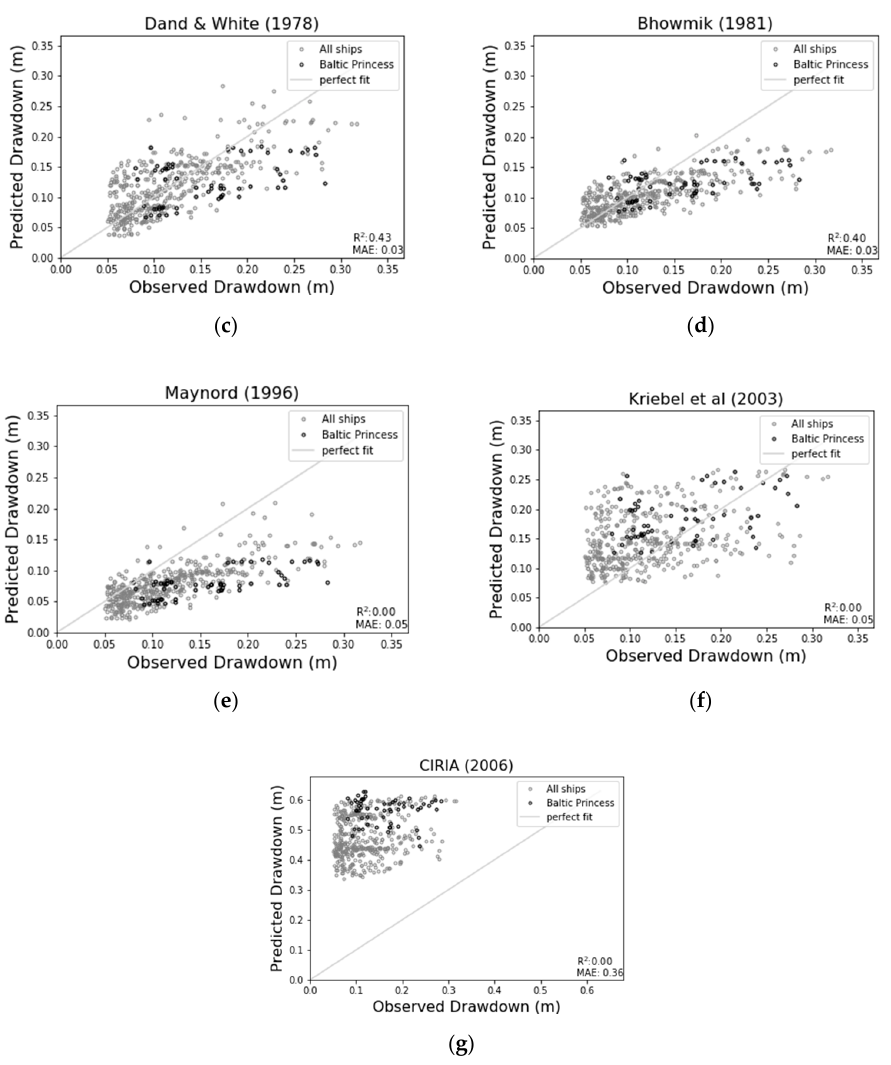
Figure 8. Calculated drawdown height with empirical equations versus measured drawdown height at Nykvarnsholme and Björnhuvud for the existing drawdown equations of Shijfs [11] ( a ); Hochstein [24] ( b ); Dand & White [25] ( c ); Bhowmik [17] ( d ); Maynord [10] ( e ); Kriebel [9] ( f ); and CIRIA [26] ( g ) Grey markers represent all ships, whereas black markers only show data for the ship Baltic Princess. The drawdown from the single ship is included to show that the scatter is not related to the lack of information about the ship hull coefficient. The grey line displays the perfect fit between measured and predicted drawdown.